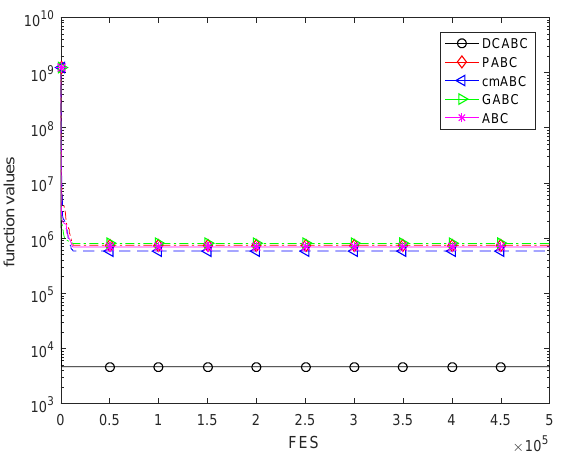
Figure 8. Convergence curves of five algorithms for f 10 with D = 50. (The optimal value of f 10 is